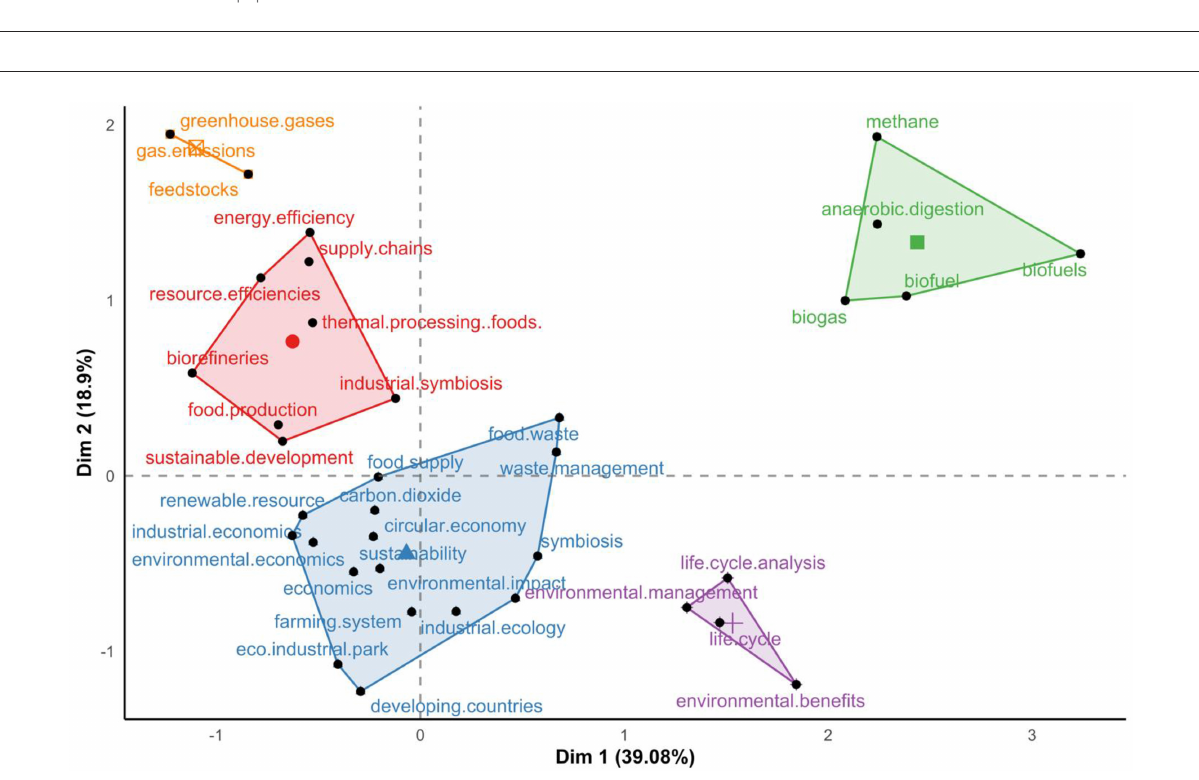
FIGURE6 Multiple correspondence analysis. Source: our elaboration using “bibliometrix” R